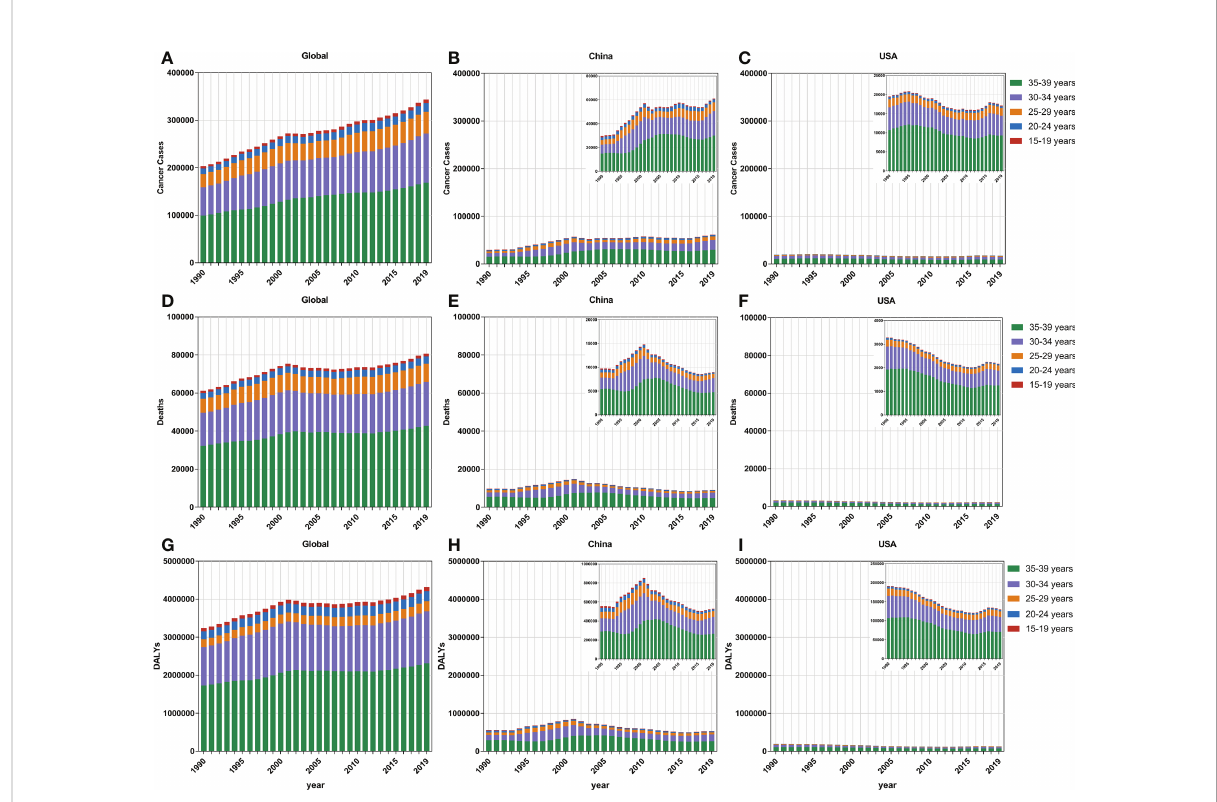
FIGURE 2 The incidence cases, mortality cases, and DALYs of FeBGCs among AYAs by age. (A – C) The incidence cases of female breast and gynecologic cancers among AYAs in the globe, China, and USA. (D – F) The mortality cases of female breast and gynecologic cancers among AYAs in the globe, China, and USA. (G – I) The DALYs of female breast and gynecologic cancers among AYAs in the globe, China, and USA. AYAs, adolescents and young adults; DALYs, disability-adjusted life years; FeBGCs, female breast and gynecologic cancers; USA, the United States of